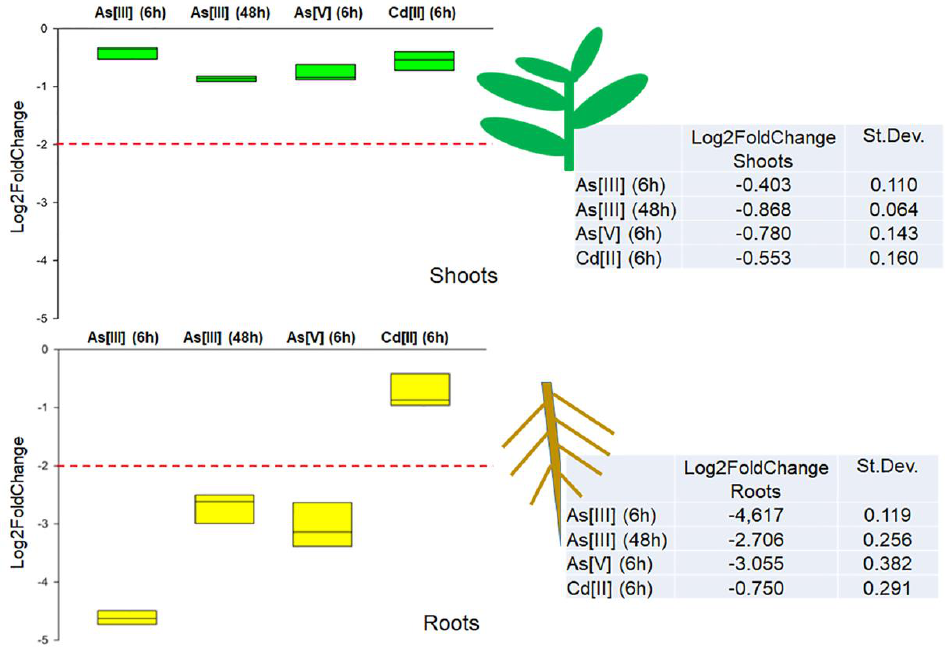
Figure 4. Quantitative real-time polymerase chain reaction of DvNip1.1 in shoots and roots of DI3- F plants subjected to As[III] (6 h), As[III] (48 h), As[V] (6 h), and Cd[II] (6 h). The expression of DvNip1.1 gene is reported as transcript inhibition level (log2 of fold change) with respect to control (without HM). The results of three independent biological and three technical replicates are presented with box plots (middle bar, median; box limits, upper and lower quartiles; whiskers, min. and max. values).